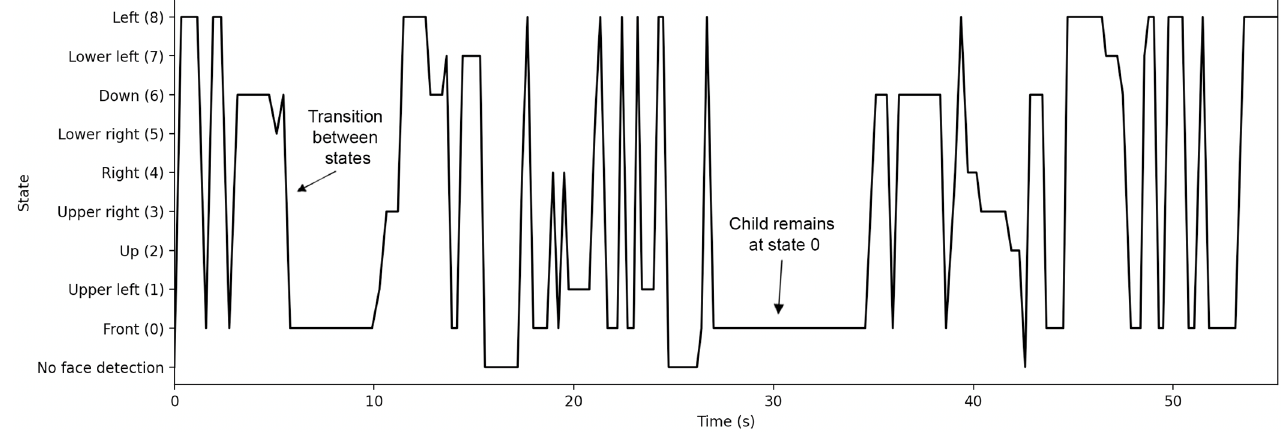
Figure 10. A child’s states during an eligible attempt that includes complete